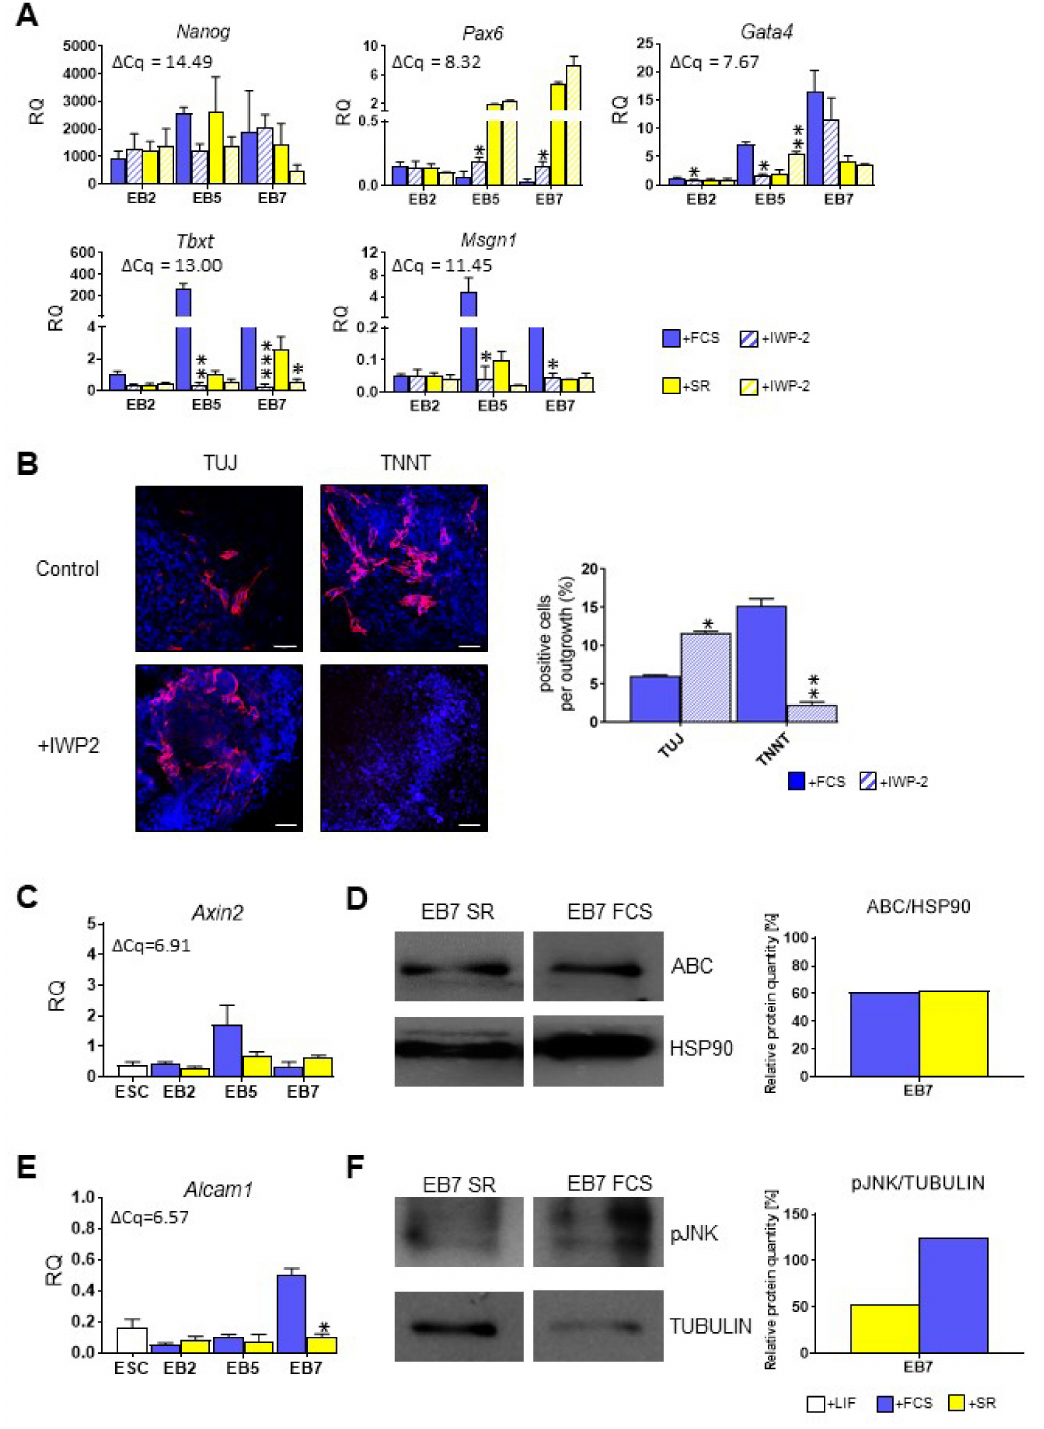
Figure 5. Analysis of WNT secretion inhibition and WNT pathway activity in mouse ESCs cultured in medium supple- mented either with FCS or SR. ( A ) Expression of Nanog , Pax6 , Gata4 , Tbxt , and Msgn1 in control and IWP-2-treated